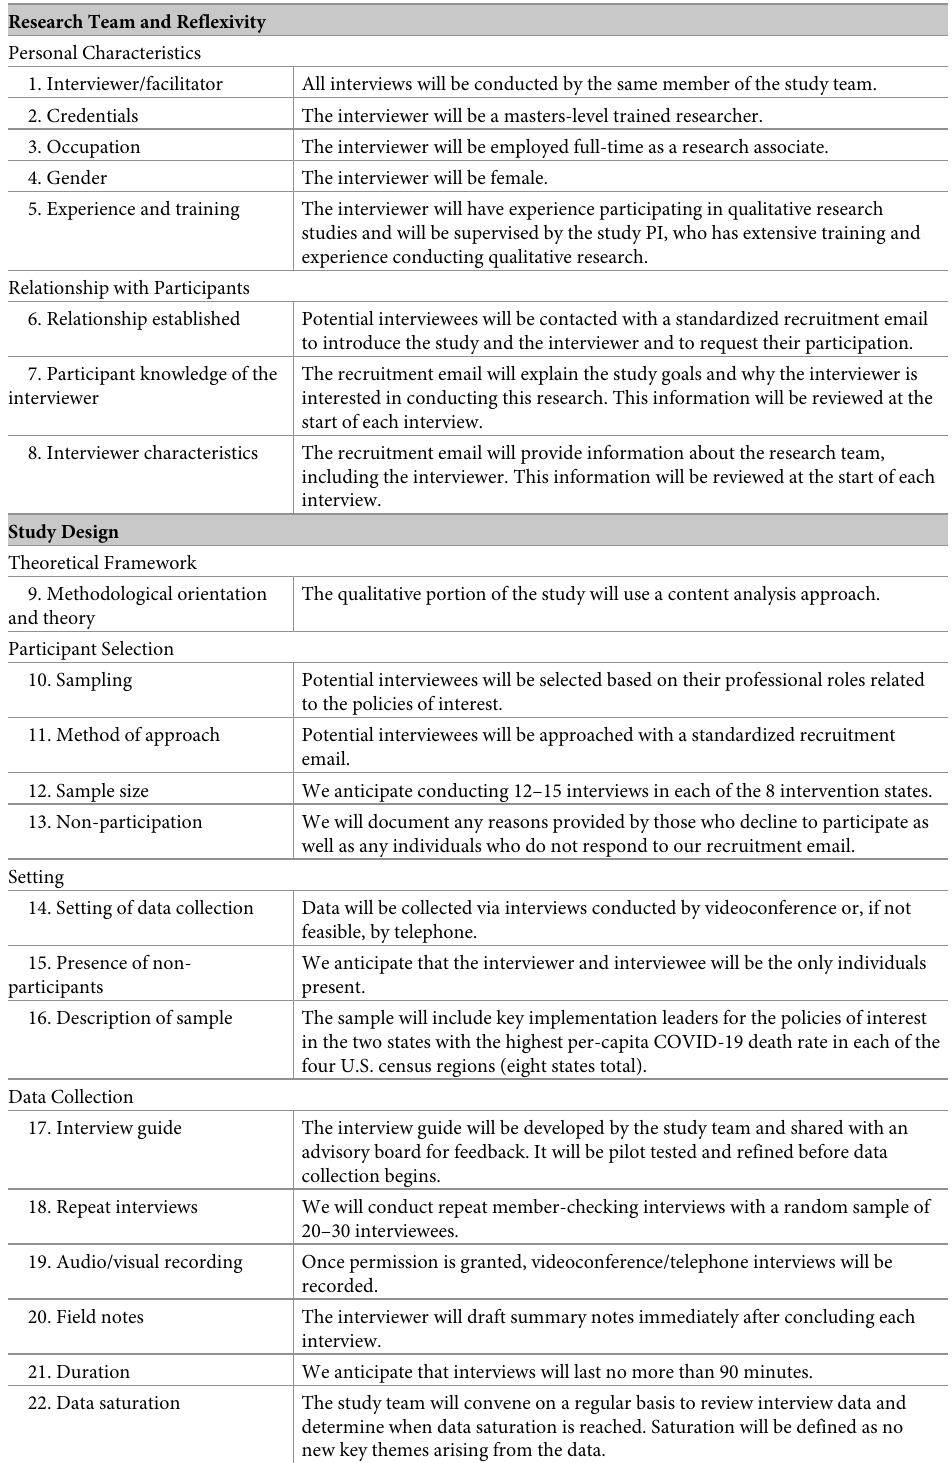
Table 2. Qualitative study